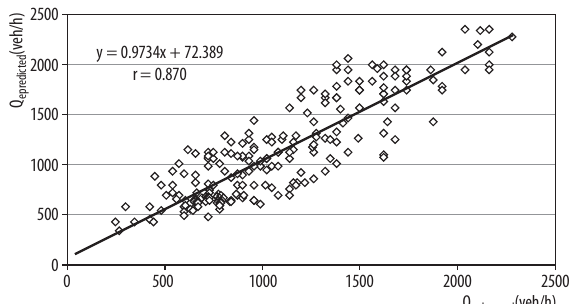
Fig. 6. Comparison of the observed and predicted values using equation